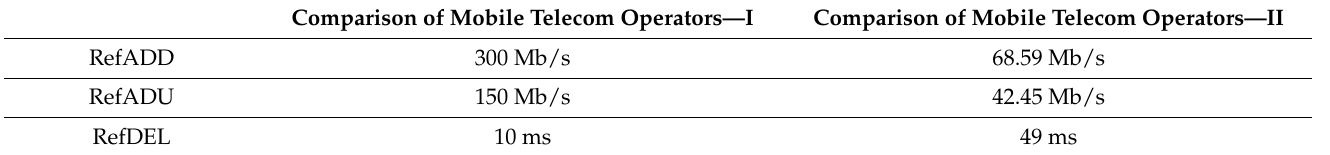
Table 5. Reference values for the MDMG item (Ref).